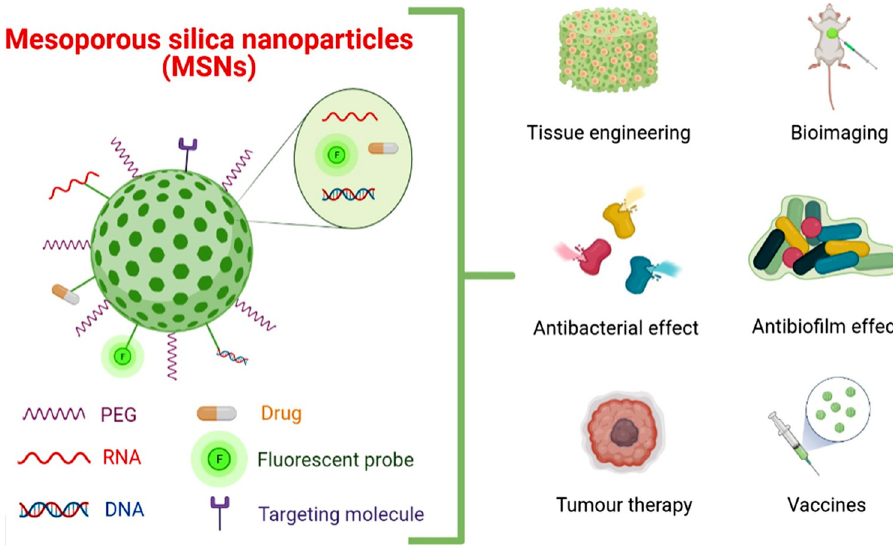
Figure 7: Mesoporous silica nanoparticles ( MSNs ) functionalization and biomedical applications. Biological molecules ( e.g. , fl uorescent probes, drugs, DNA, and RNA ) can be encapsulated in the pores or conjugated to the surface of MSNs just as targeting molecules and PEG. Fictionalized MSNs are employed not only in tissue engineering, bioimaging, tumour therapy, and vaccines but also in antibacterial and antibio fi lm